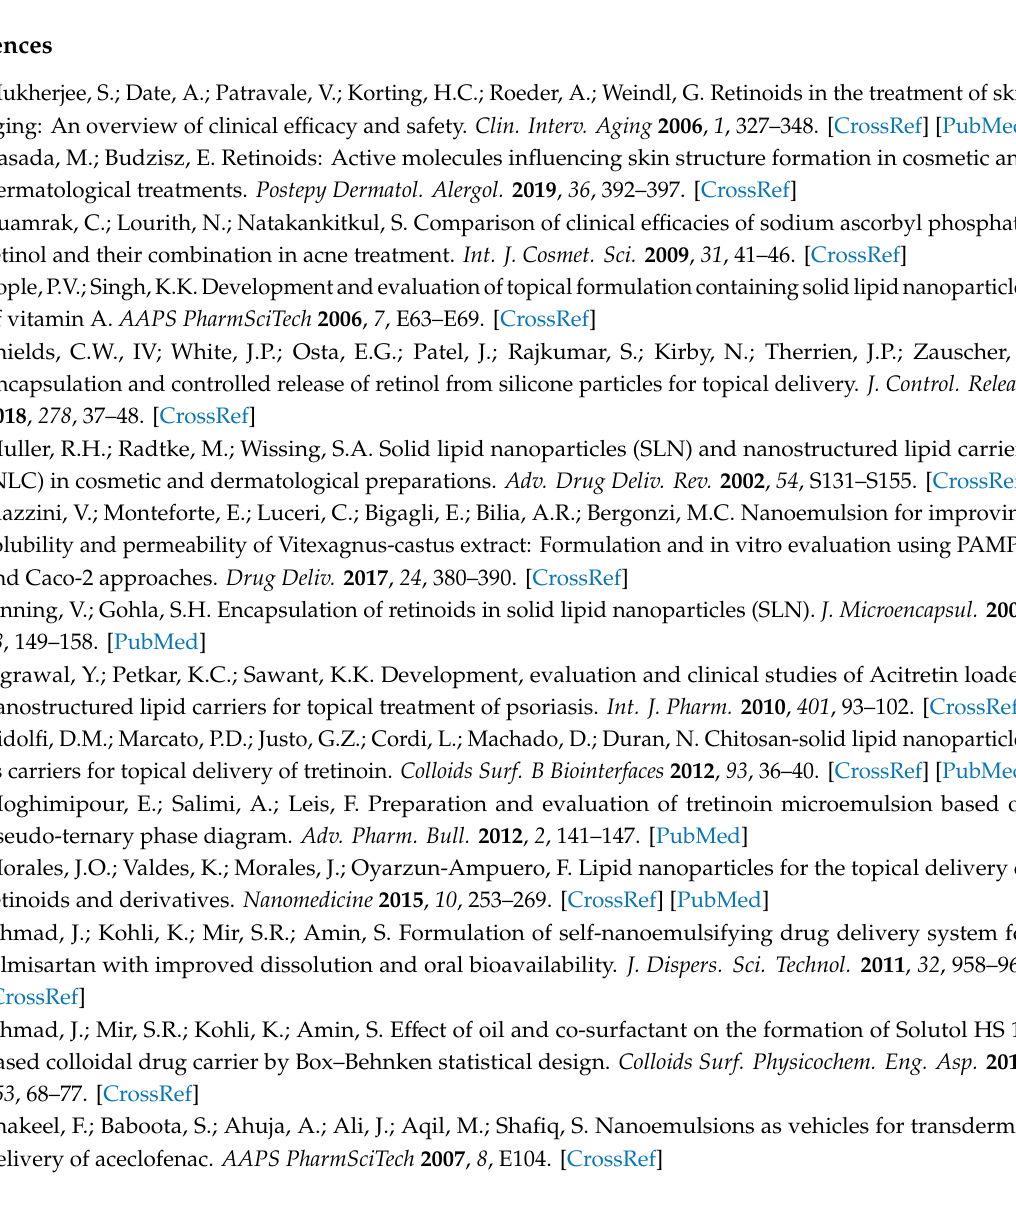
Figure S1: Droplet size (71.97 nm with PdI 0.619) and zeta potential ( − 19.1 mV) of NE1; Figure S2: Droplet size (45.46 nm with PdI 0.204) and zeta potential ( − 19.4 mV) of NE2; Figure S3: Droplet size (19.06 nm with PdI 0.125) and zeta potential ( − 20.1 mV) of NE3; Figure S4: Droplet size (16.63 nm with PdI 0.016) and zeta potential ( − 20.6 mV) of